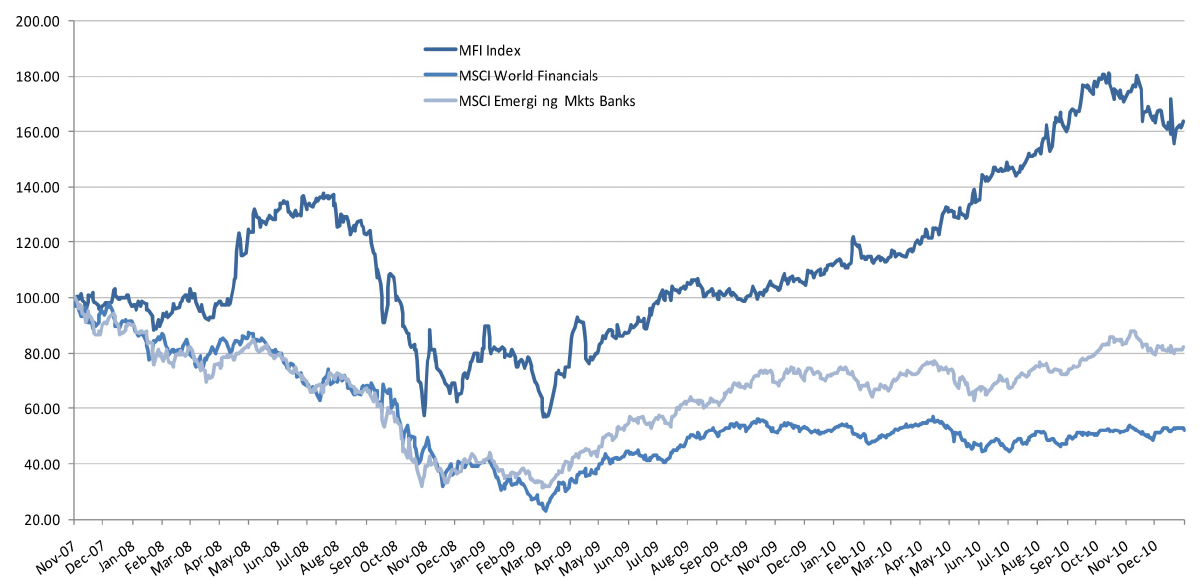
Figure 6. Performance of four listed MFIs vs the MSCI Global Financials Intuitions Index and the MSCI Emerging Markets Financials Intuitions